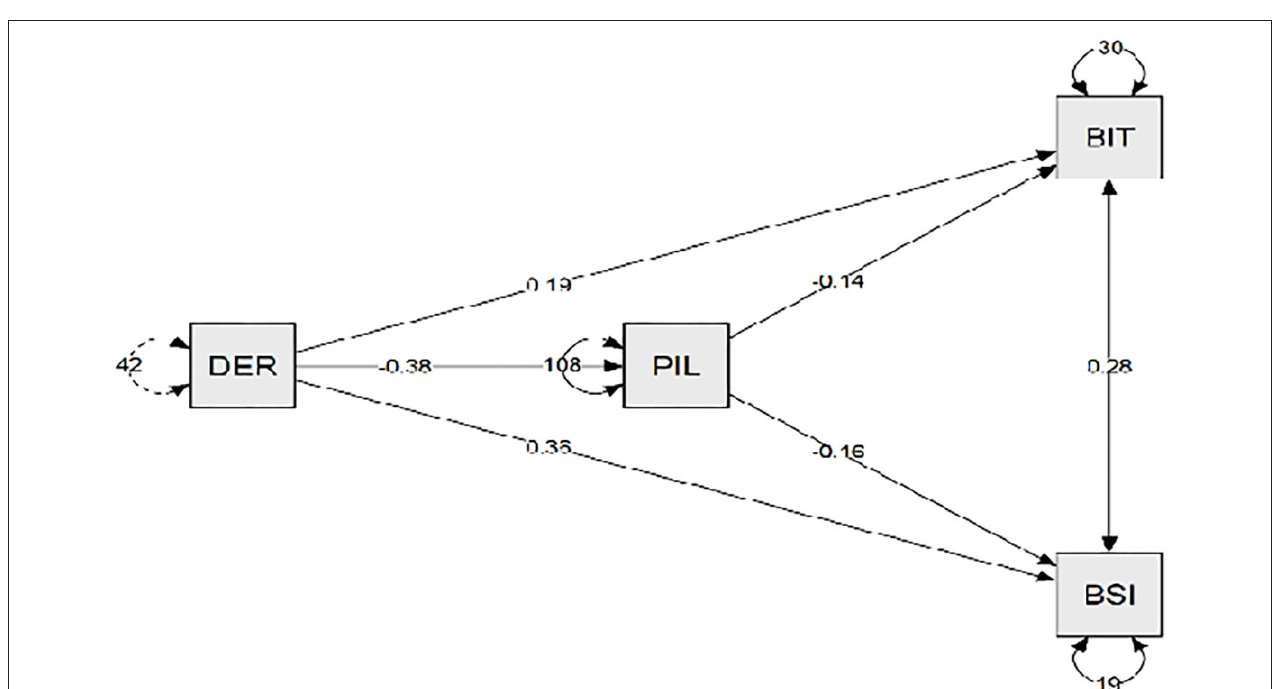
FIGURE 2 | The meaning in life is a mediating variable between the emotional deregulation and binge eating disorder psychopathology, and depression in participants with overweight. DER, emotional deregulation; PIL, purpose in life; BIT, Bulimic Inventory Test Edinburgh; BSI, depression subscale of the Brief Symptoms Inventory.